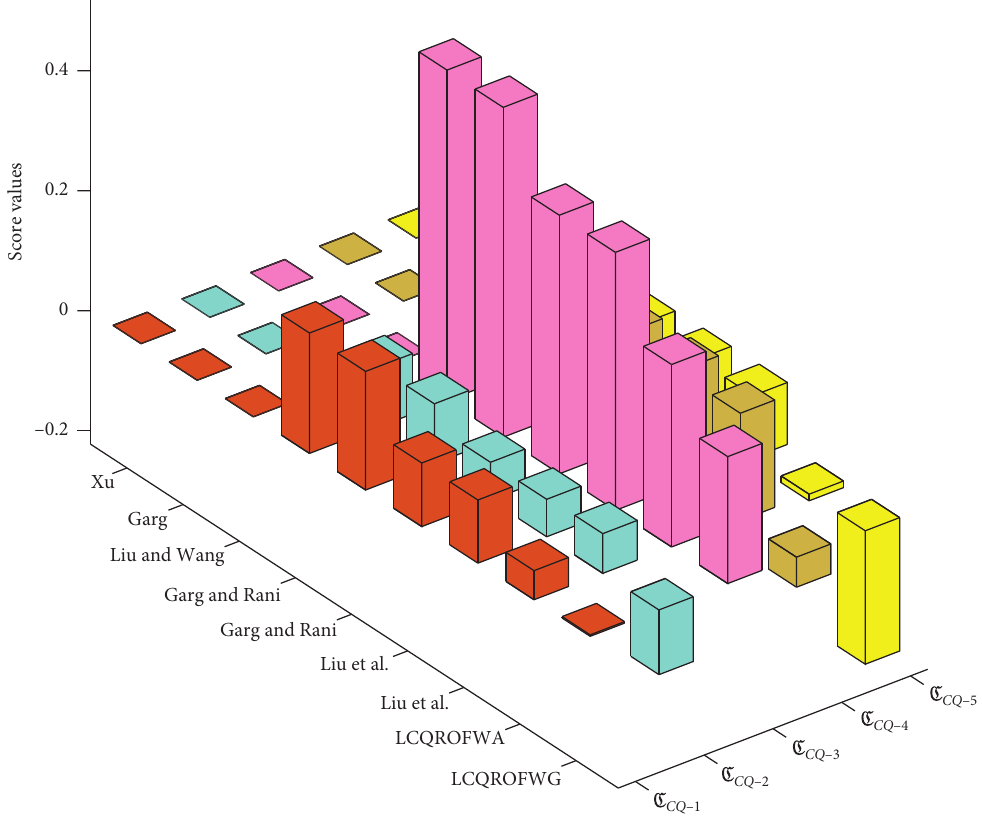
Figure 6: Geometrical representation of the score values of the alternatives given in Table